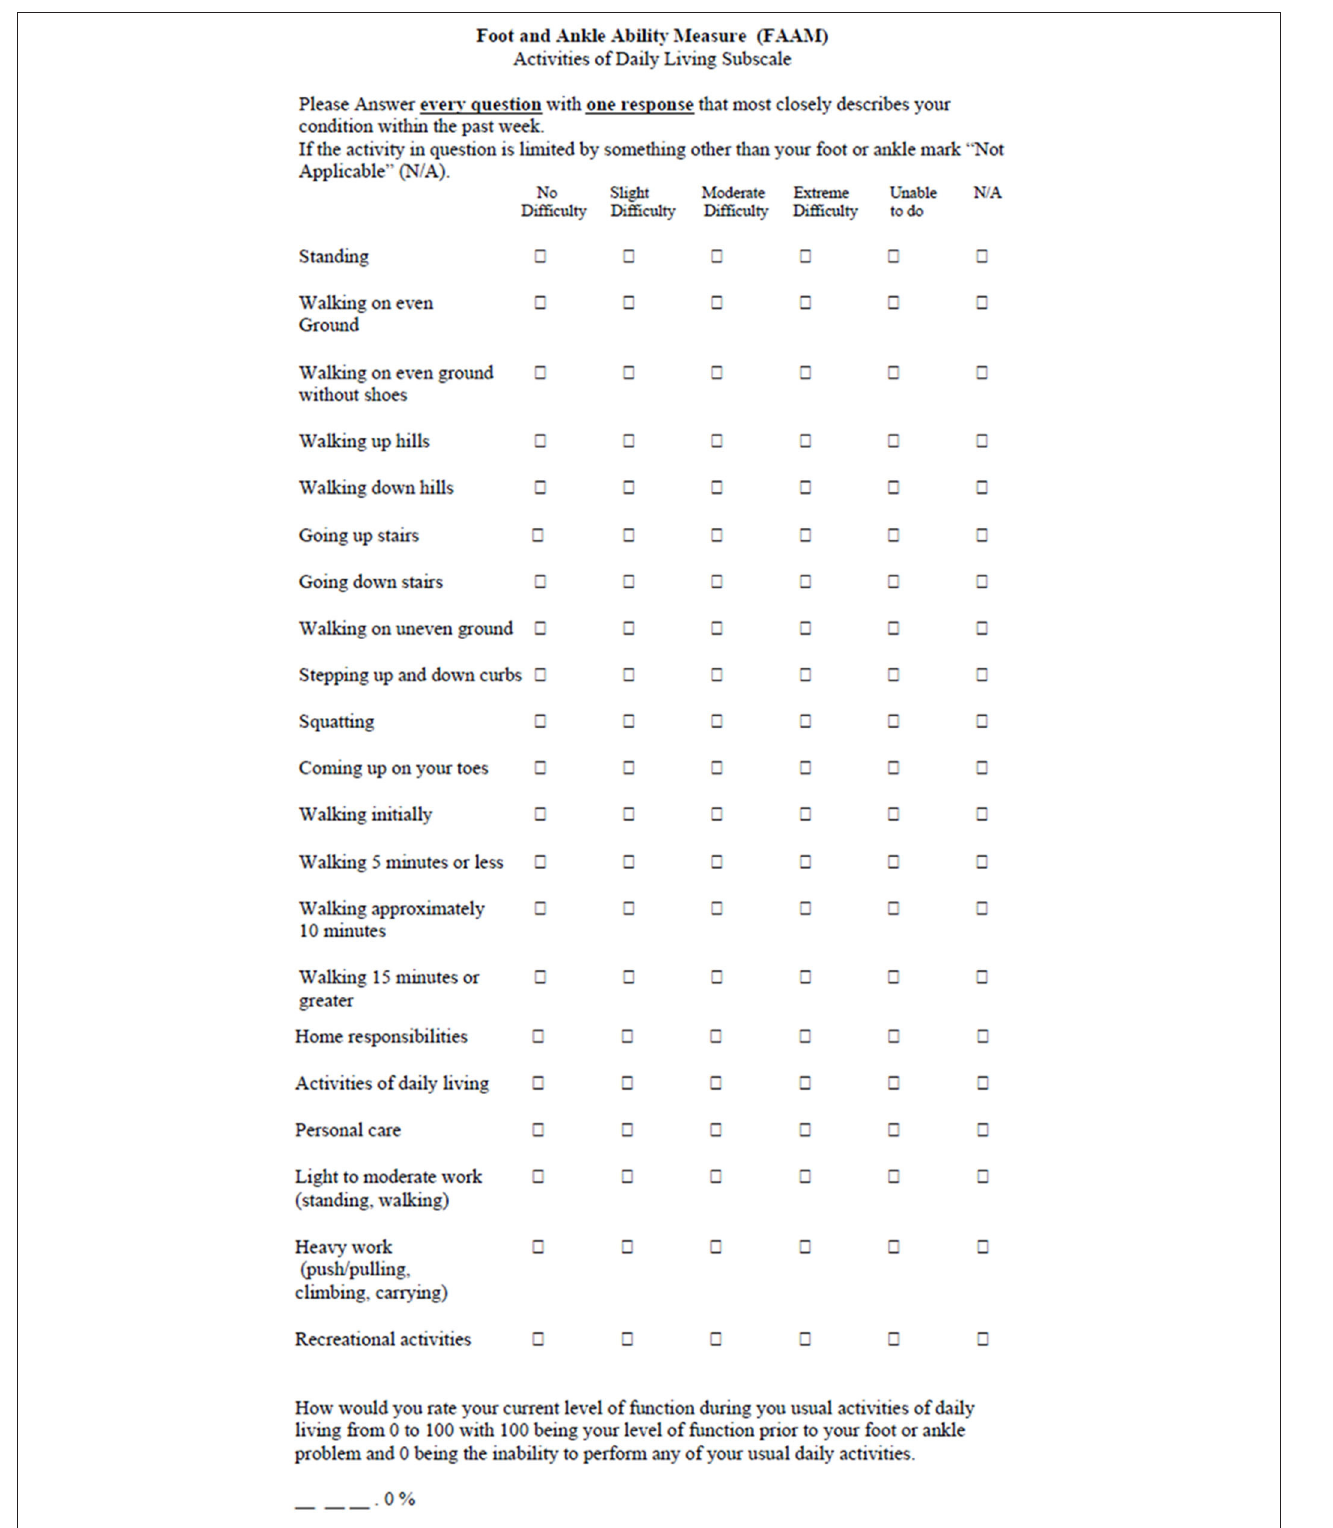
FIGURE 5 | Foot and ankle ability measure, activities of daily living subscale (FAAM adl ).